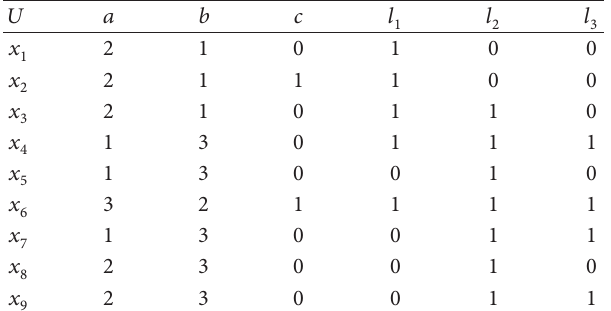
Table 1: A multilabel decision